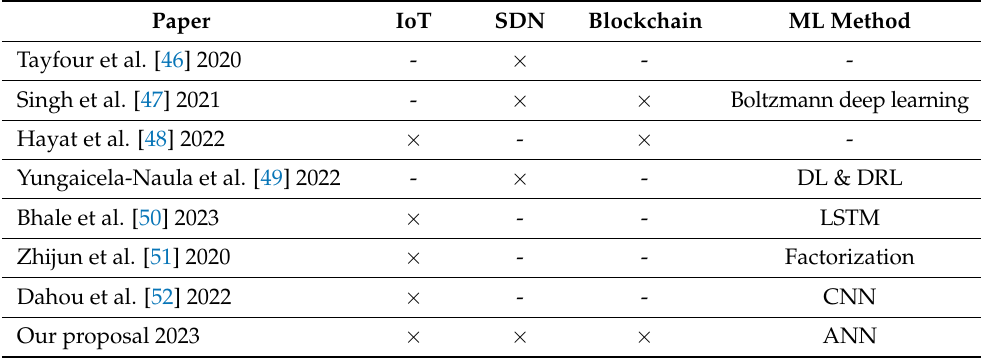
Table 2. Summary of DDoS attack detection and mitigation techniques. Paper